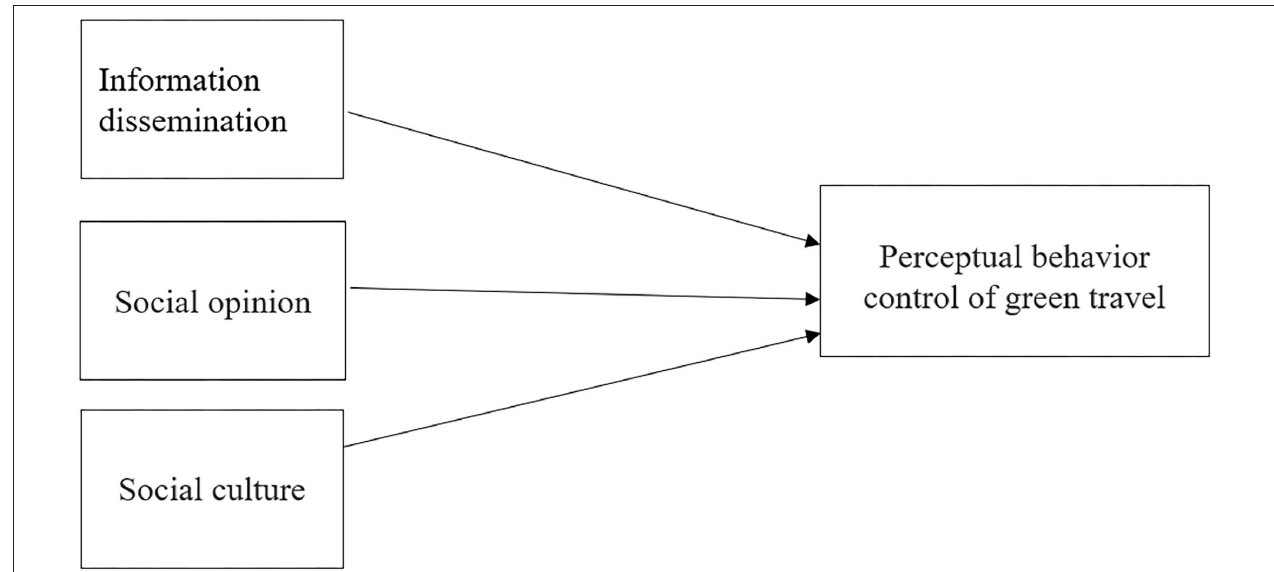
FIGURE 3 | Influence process of social propaganda policies on public perceived behavior control of green